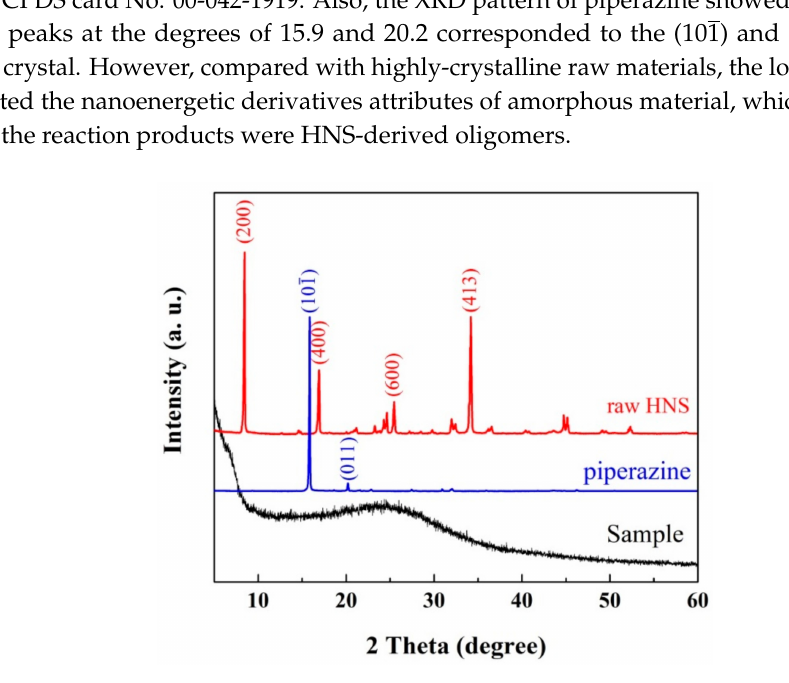
Figure 6. The XRD patterns of raw HNS (red), piperazine (blue) and the sample: nanoenergetic derivatives